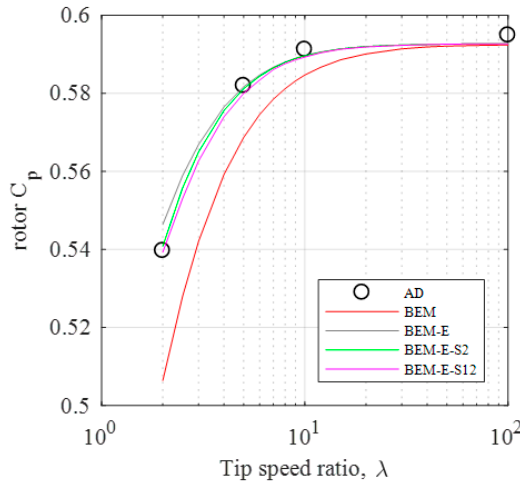
Figure 13. Optimal rotor C p versus tip-speed ratio for the AD and BEM methods.